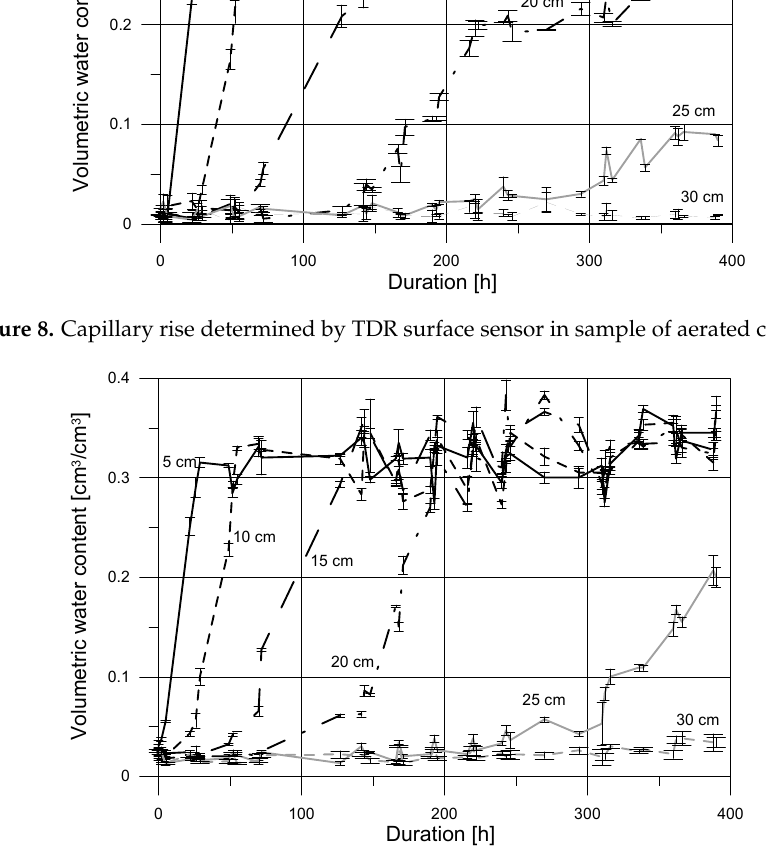
Figure 9. Capillary rise determined by FD capacitive sensor in sample of aerated concrete.